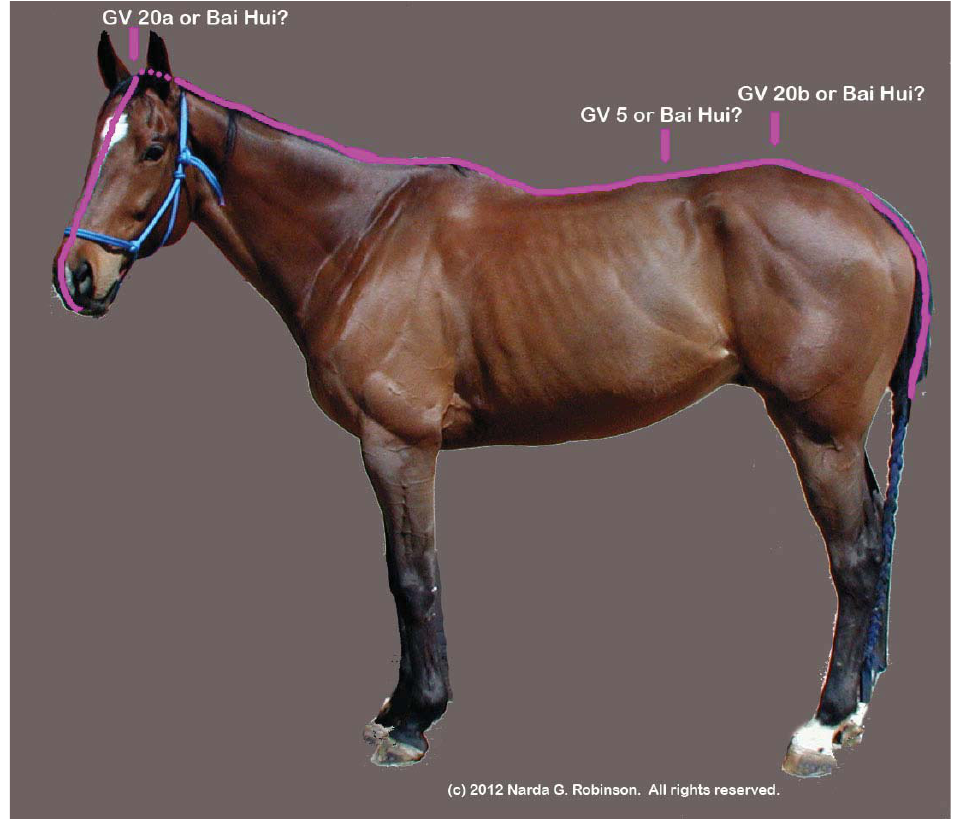
Figure 4. Translational acupuncture research studies citing Bai Hui as one of the points stimulated may be referring to GV 20a, GV 20b, or GV5. The resultant confusion imposes hurdles for researchers who attempt to replicate the study in the same or other species, clinicians who try to achieve the outcomes claimed in the research trial, and physiologists who strive to interpret the mechanisms of action of Bai Hui stimulation. (Image courtesy of Narda G. Robinson, DO, DVM, MS and Colorado State